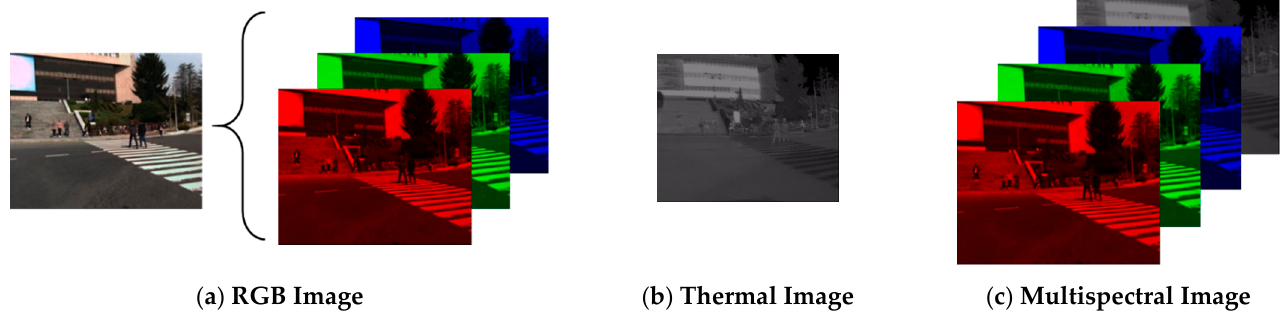
Figure 1. Three image sources are utilized: ( a ) RGB, ( b ) thermal and ( c ) multispectral images. The RGB image and the thermal image are taken by the dataset. The RGB image can be decomposed into red, green and blue channels. Thermal image only has one channel. Multispectral image consists of a concatenation of three channels of RGB image and one channel of thermal image.